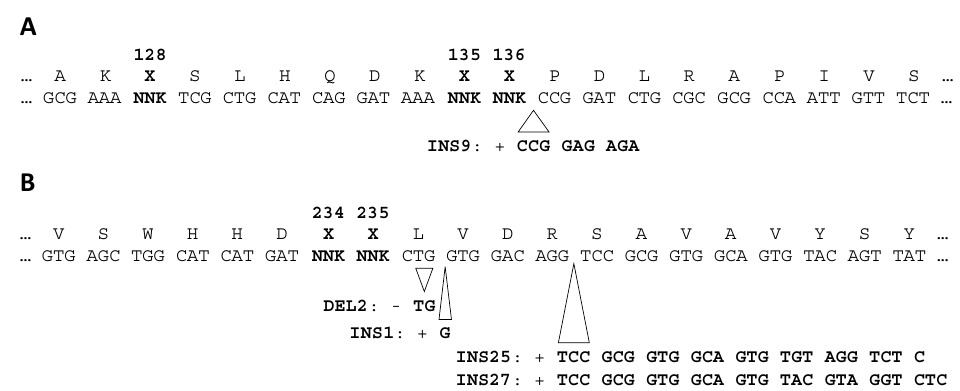
Figure 2. Enriched insertions (INS) and deletions (DEL) observed downstream of randomized codons (bolt) in AlkB panel ( A ) and FTO panel ( B ) coding sequences.